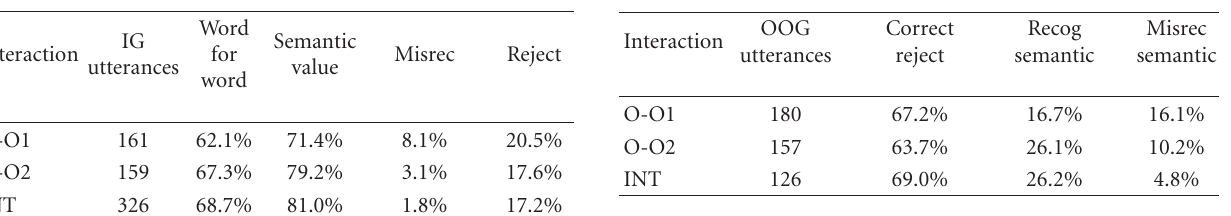
Table 4: In-grammar recognition accuracy. Table 5: Out-of-grammar recognition.